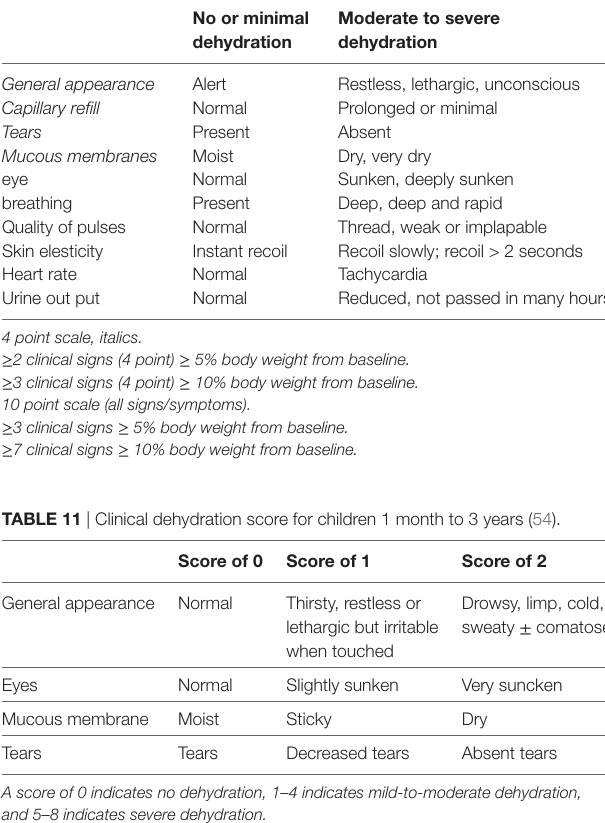
TABLe 10 | Gorelick scale for dehydration used in children between 1 month and 5 years (54). No or minimal dehydration